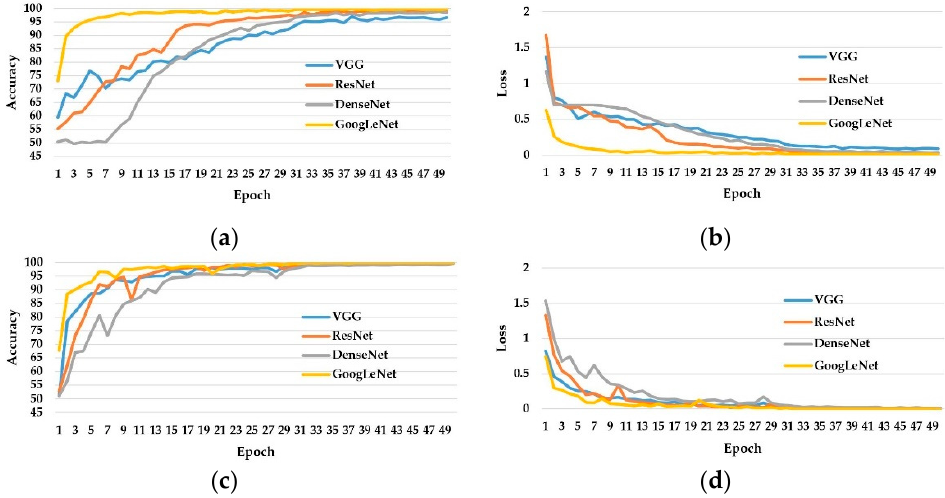
Figure 14. Training process. ( a , b ) Model accuracy and loss when trained on original electrical wire image dataset; ( c , d ) Model accuracy and loss when trained on cropped electrical wire image dataset.